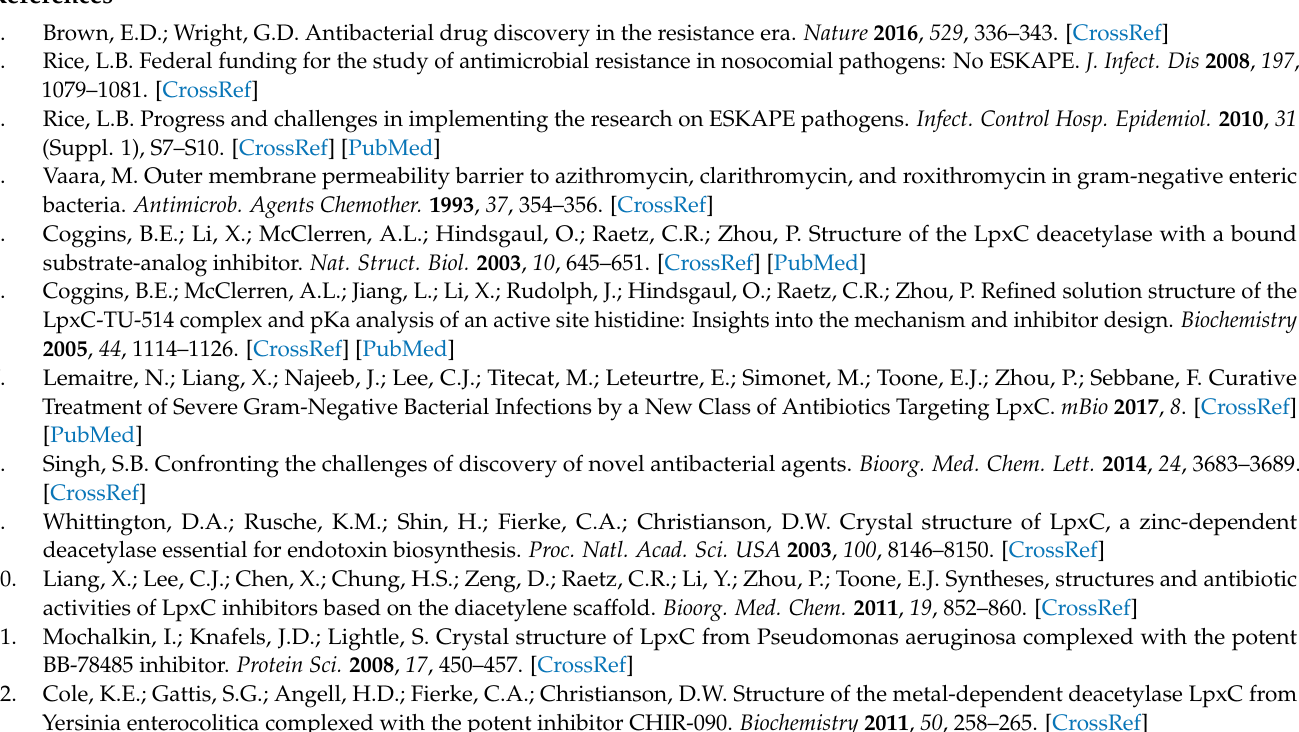
Figure S5: Superimposition of EcLpxC/ACHN-975 and YeLpxC/ACHN-975 with AaLpxC/ACHN- 975 structures, Figure S6: Structural comparison of AaLpxC/ACHN-975 with AaLpxC/LPC-009 and AaLpxC/CHIR-090, Figure S7. Schematic of recommended ACHN-975 derivatives; Table S1: Primers for site-directed